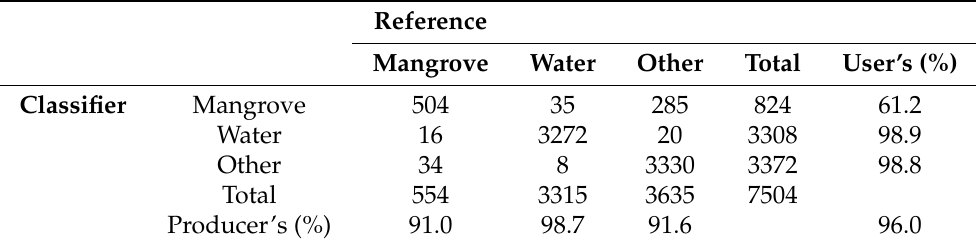
Table 5. Results of spatiotemporal accuracy assessment for French